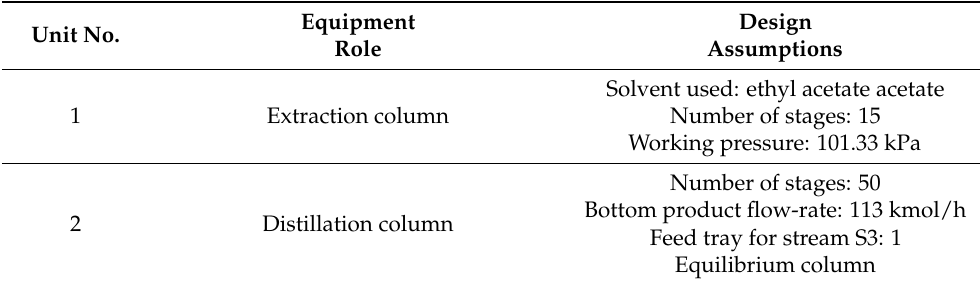
Table 1. Design assumptions of the main units for case 1.